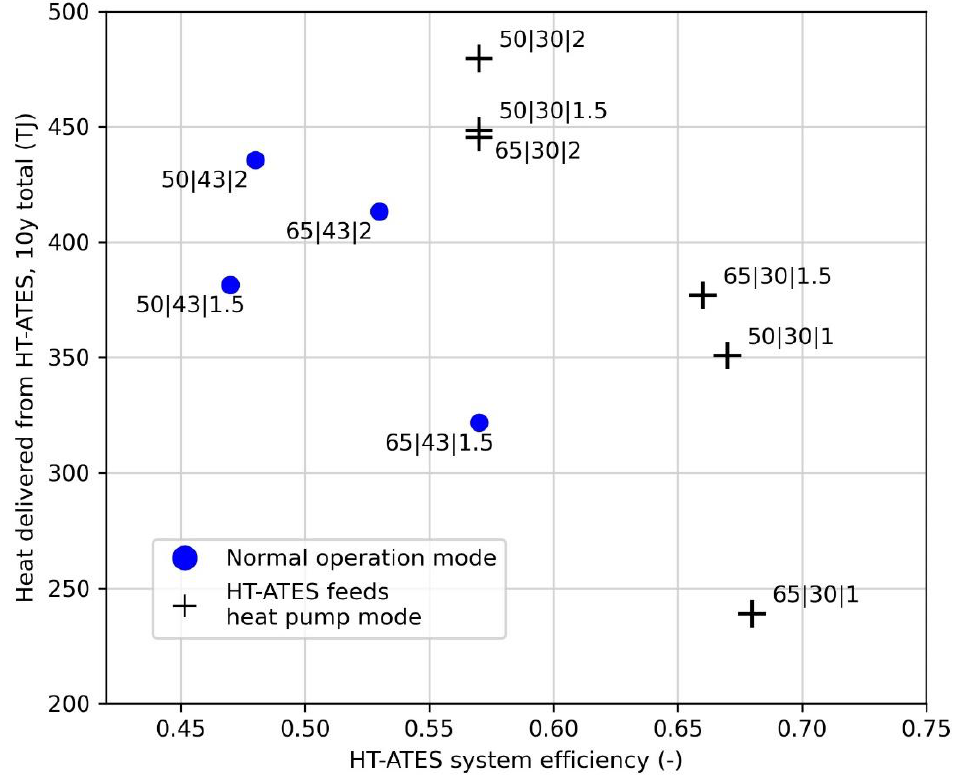
Figure 9. The absolute amounts of delivered heat (y-axis) vs. the HT-ATES system efficiency (x-axis) for the ten modelled scenarios. An optimal system would have both a high amount of delivered heat (TJ) and a high HT-ATES system efficiency. The HT-ATES feeds heat pump mode provides a more efficient HT-ATES system for all scenarios.